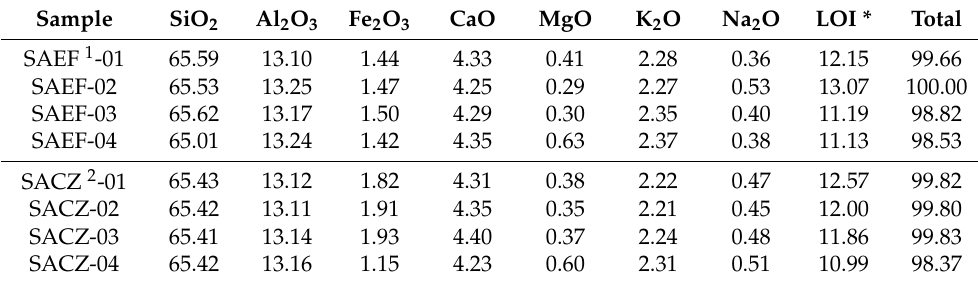
Table 3. Results of the X-ray fluorescence analysis obtained by studying the samples.